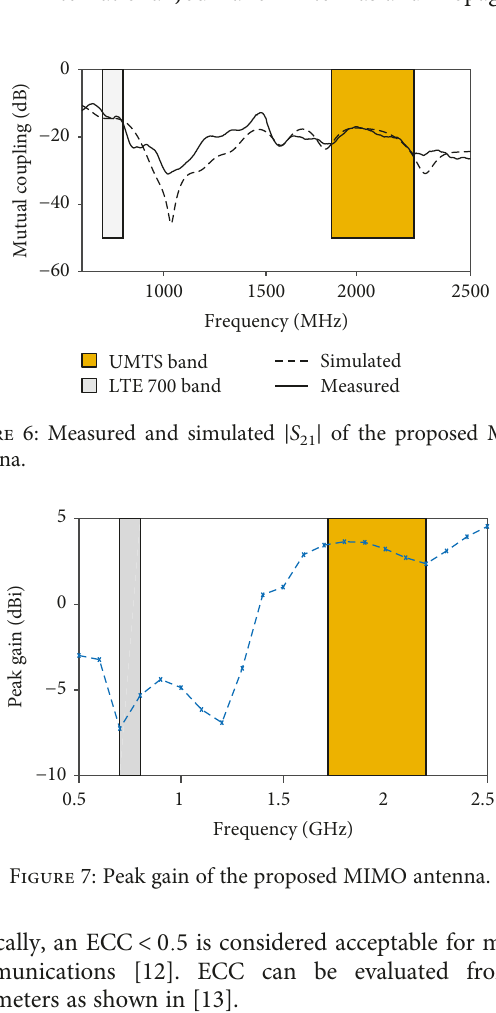
| of the proposed MIMO 21